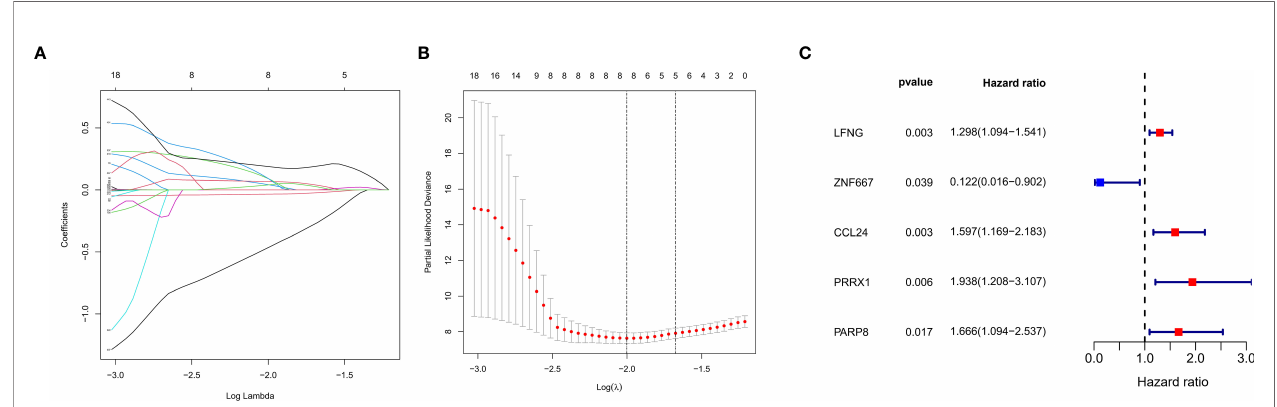
FIGURE 4 | Construction of a prognostic gene signature using a LASSO – Cox regression model. (A) Trend graph of LASSO coef fi cients for 450 genes from univariate Cox regression analysis. the abscissa represents the log value of the optimal parameter (lambda), the ordinate represents the coef fi cient of the variable. (B) Attainment of lambda by a minimum combination of eight genes. Dotted vertical lines were drawn at the optimal values by using the minimum criteria and the 1 standard error (SE) of the minimum criteria (the 1 − SE criteria). (C) Multivariate Cox analysis of previously screened genes, red dots represent the possible risk factors while blue represents potential protective